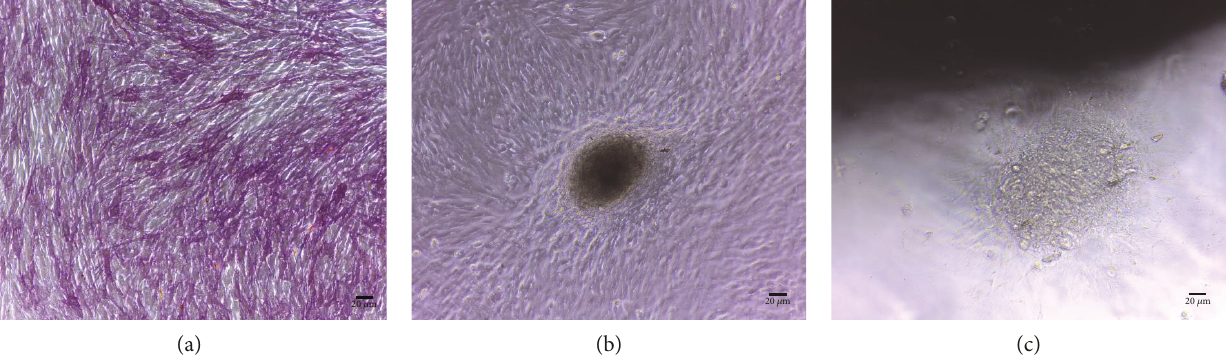
Figure 1: (a) In vitro appearance of BMSSCs forming a matrix nodule after two weeks of culture in the presence of osteoblast di ff erentiation medium. (b) Cultures of BMSSCs stained for ALP expression. (c) In vitro appearance of BMSSCs forming a matrix nodule in proximity of BPB before grafting.